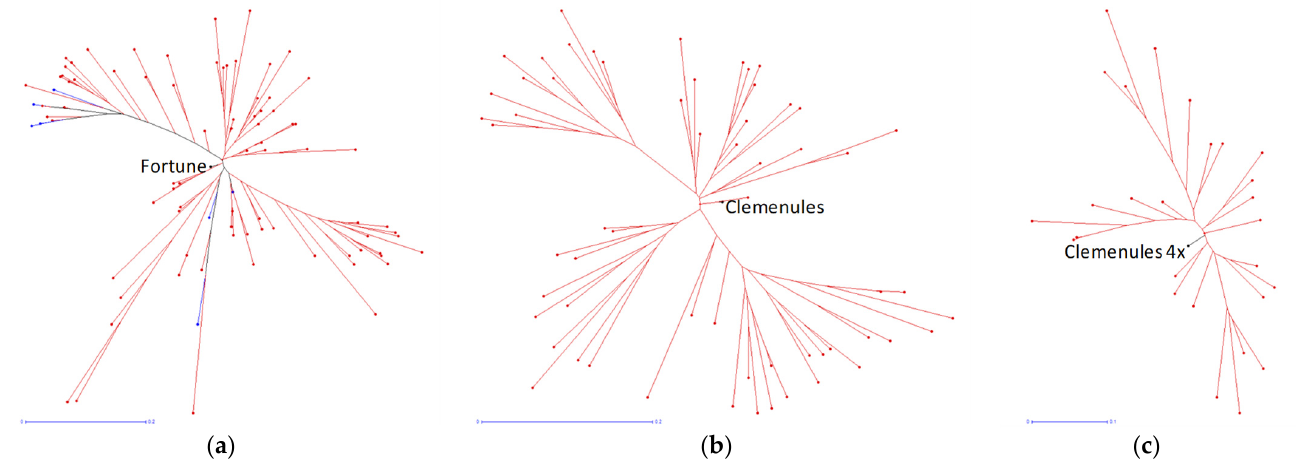
Figure 5. ( a ) Neighbor-joining tree obtained from the allelic data of the diploid hybrid population recovered from the self-pollination of the ‘Fortune’ mandarin by temperature stress (blue) and bud pollination (red). ( b ) Neighbor-joining tree obtained from the allelic data of the diploid hybrid population recovered from the self-pollination of the ‘Clemenules’ clementine by bud pollination. ( c ) Neighbor-joining tree obtained from the allelic data of the tetraploid hybrids population recovered from the self-pollination of the tetraploid ‘Clemenules’ clementine. The scale for genetic distances over edge is indicated by the blue line length; 0.2 for ( a , b ), and 0.1 for ( c ). Table 2. Analysis of Mendelian allelic segregation (Chi-squared test with Bonferroni correction for multiple testing) of the recovered plants from the self-pollinated buds of the ‘Fortune’